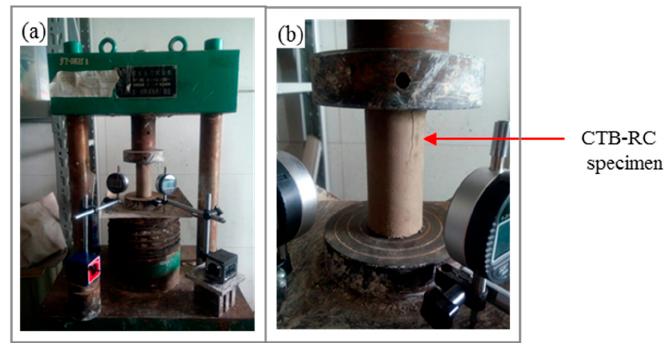
Figure 7. (a ) The UCS tester and ( b ) the CTB-RC specimen fractured under the UCS test. Figure 7. ( a ) The UCS tester and ( b ) the CTB-RC specimen fractured under the UCS test.